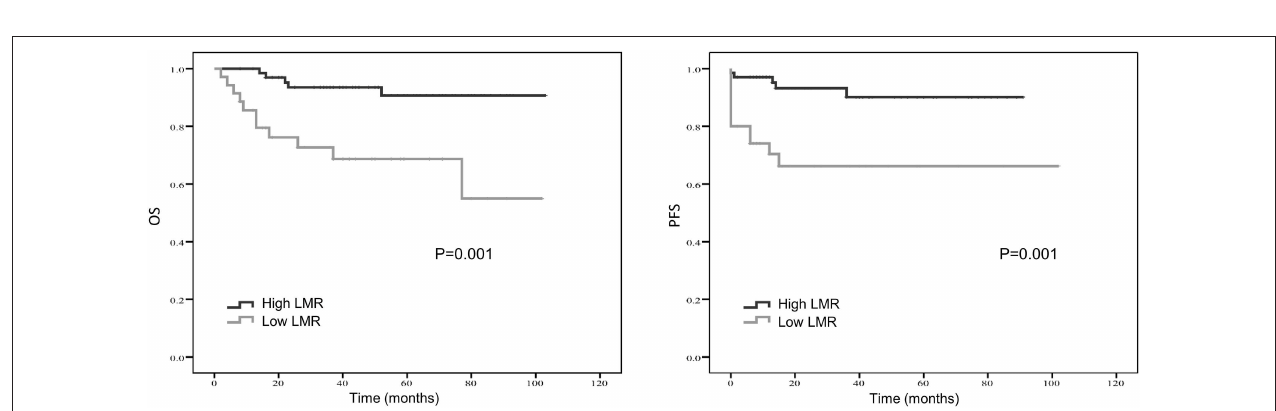
FIGURE 2 | Kaplan-Meier estimates of overall survival (OS) and progression-free survival (PFS) probability according to pre-treatment platelet-to- lymphocyte ratio (PLR) level.